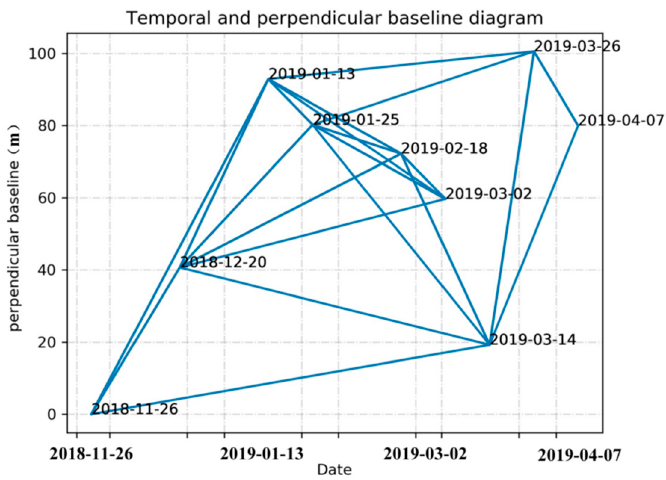
Figure 7. Temporal and perpendicular baseline distributions of the remaining small-baseline InSAR pairs.